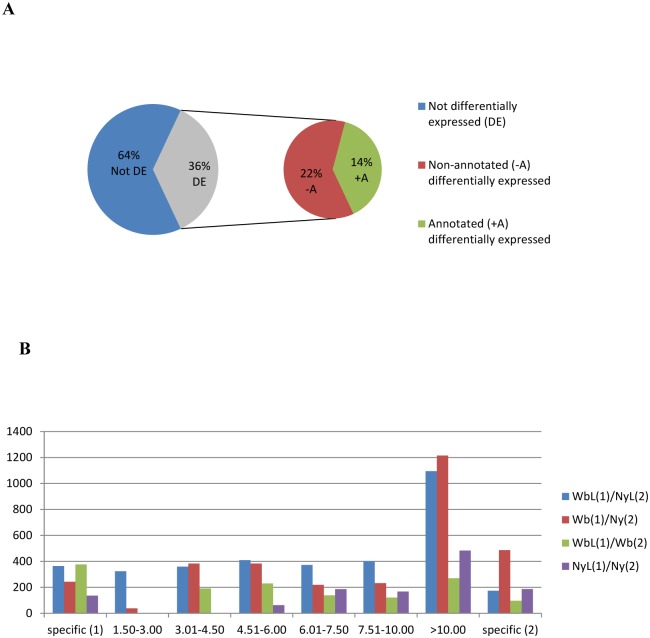
The number and distribution of differentially expressed (p<0.05) contigs for CLas-infected (L) and uninfected (no label) adults (Wb) and nymphs (Ny) of the Asian citrus psyllid (ACP).Pairwise comparisons were carried out for the following combinations: adults, uninfected and infected (Wb x WbL), nymphs, uninfected and infected (Ny x NyL), uninfected adult and nymphs (Wb x Ny), and infected adults and nymphs (WbL x NyL). For each comparison, the term represents the first library in each respective comparison. The number 1 refers to: Wb, Ny, Wb, and WbL, and the number 2: refers to WbL, NyL, Ny, and NyL.